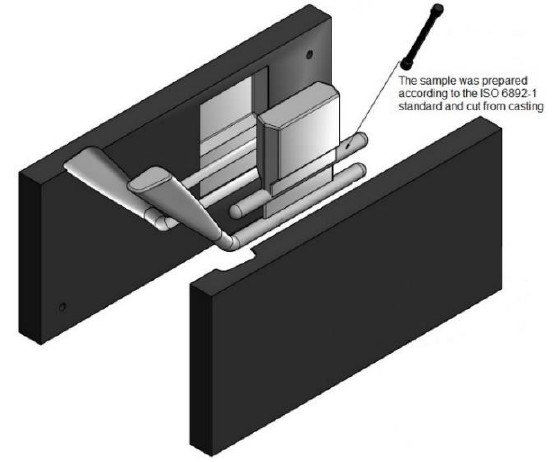
Figure 1. Metal mold for the pouring of the test pieces.